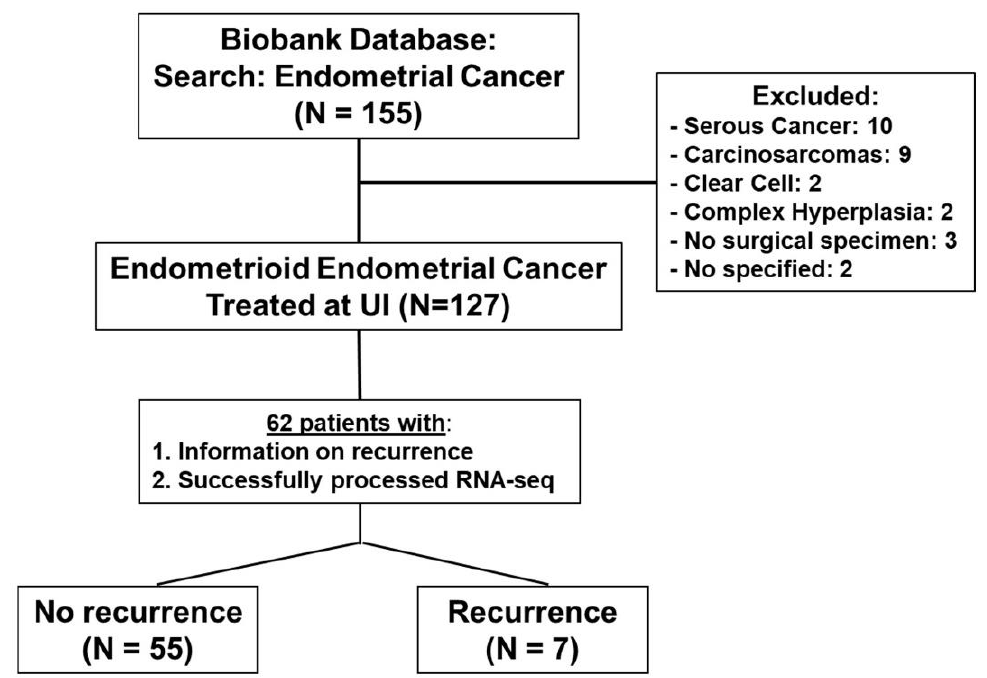
Figure 1. Flow of included patients in analysis. Of the initial 155 endometrial cancers available in the UI Biobank, 127 were confirmed to be of endometrioid histology. The rest were excluded from the study. A total of 62 patients had annotated follow-up with detailed recurrence information and with quality RNA for RNA sequencing